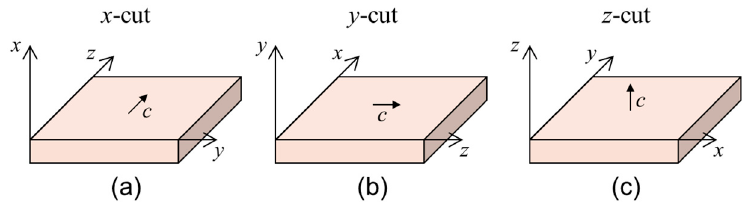
Figure 2. Different orientations of the PV substrate with the polar c -axis parallel to the active surface ( a , b ) or perpendicular to it ( c ). Note that the c -axis is taken always along the z direction.